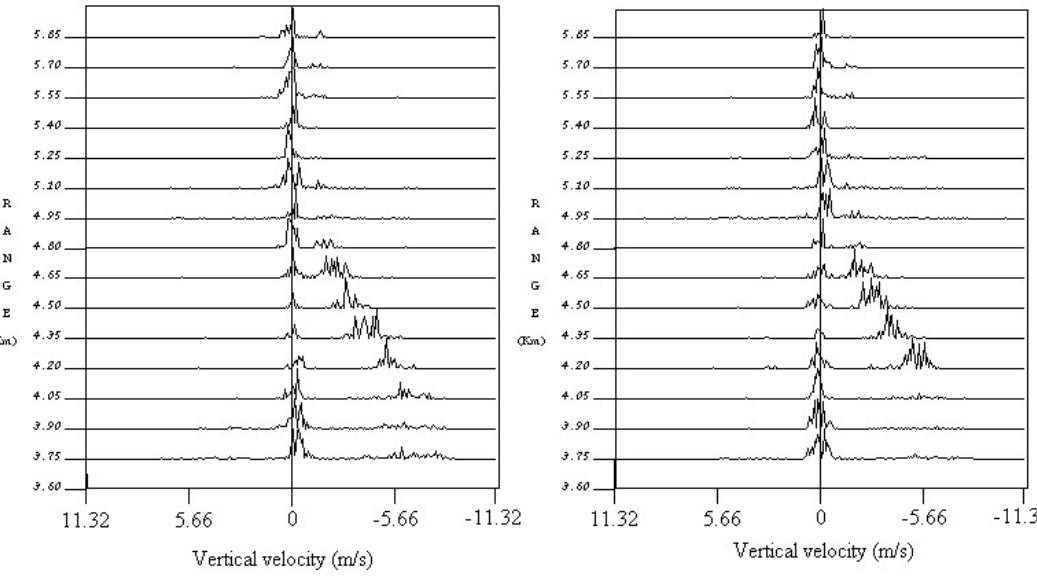
Fig. 10. Typical VHF radar power spectra observed in stratiform regions of a mesoscale convective system at two different times on 4 November 1997.